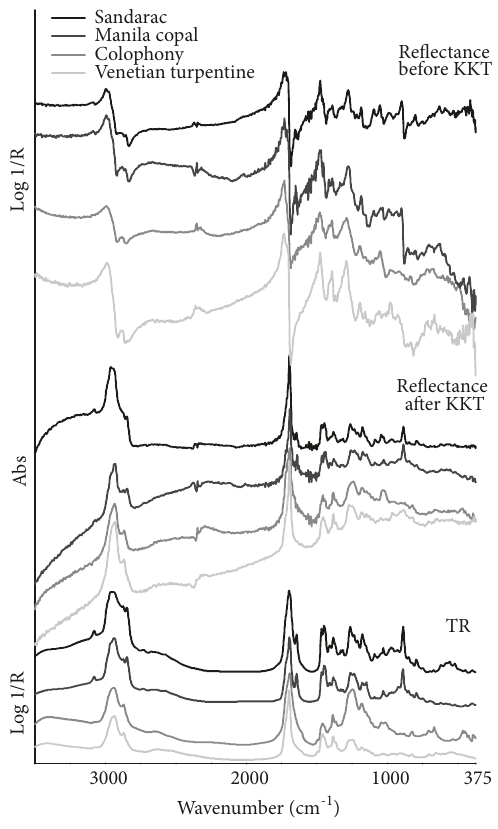
Figure 6: FTIR spectra in the mid-infrared region of the studied diterpenoidresins(blackline:sandarac,darkgrayline:Manilacopal, gray line: colophony, light gray line: Venetian turpentine) using different analysis modes. From top to bottom: total reflection mode before the KKT correction, total reflection mode after the KKT correction, and transflection